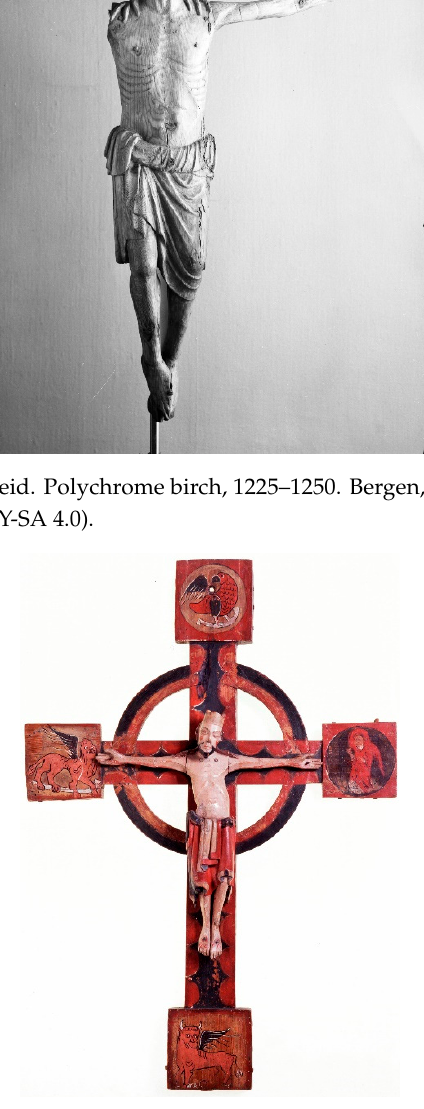
Figure 5. Crucifix from Aulstad. Polychrome oak, 1200–1220. Oslo, Museum of Cultural History, Inv. No. C33287. Photo: Erik Irgens Johnsen (CC BY-SA 4.0).